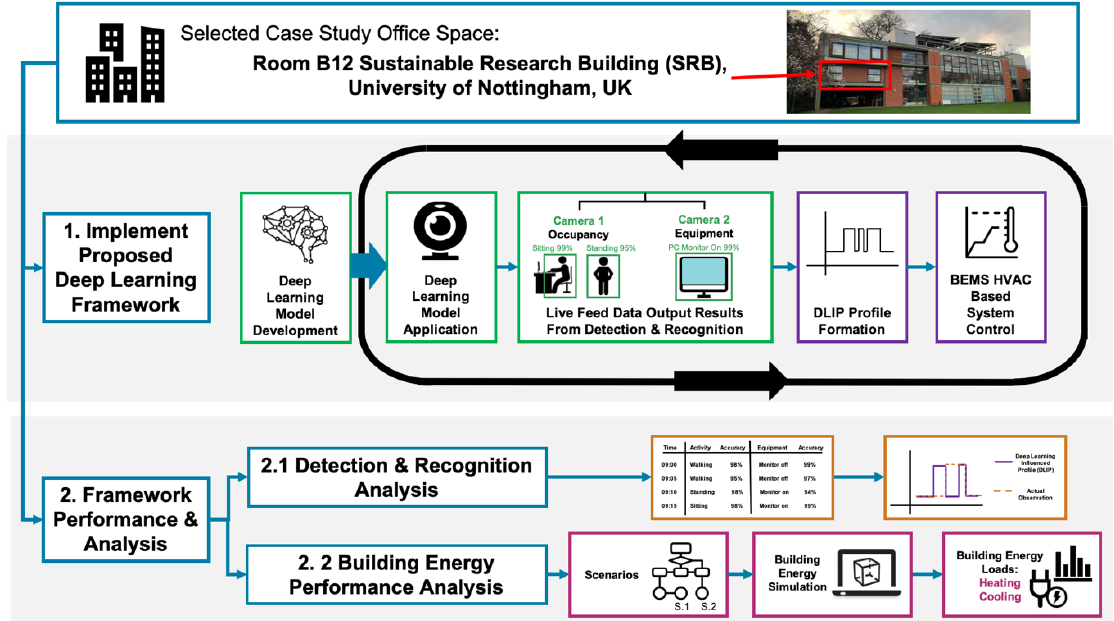
Figure 1. Research framework and method overview.